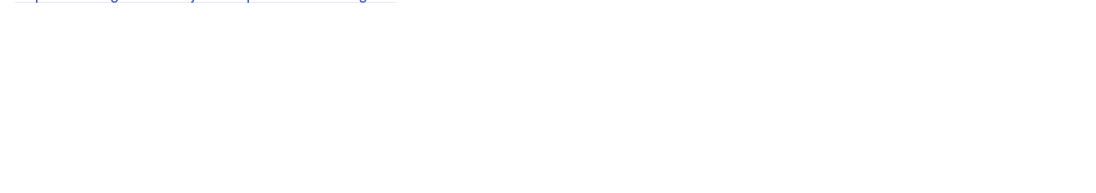
PLOS ONE | https://doi.org/10.1371/journal.pone.0275908 October 26,